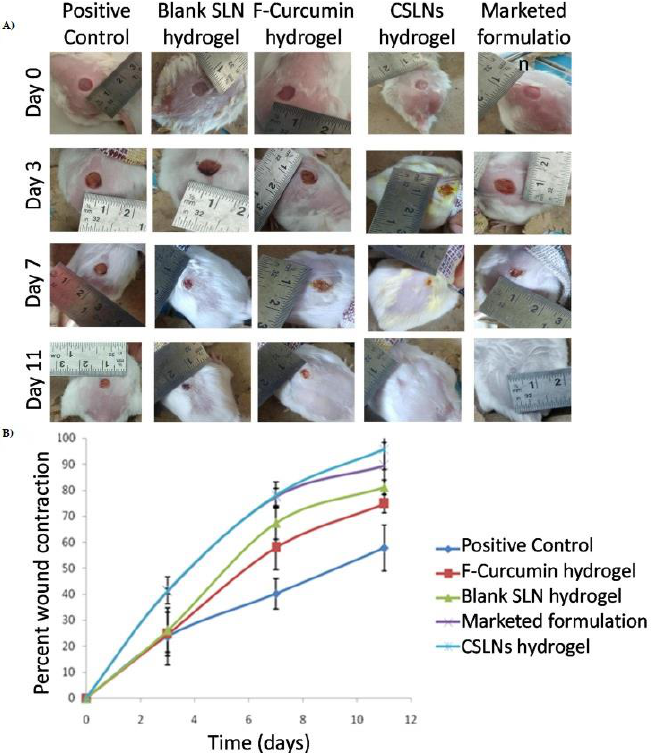
Figure 5. Effect of the treatments in the wound healing process. ( A ) Representative images of the wound healing process taken on day 0, day 3, day 7, and day 11 over the treatment; ( B ) Comparison of the percent wound contraction over the treatment. Data are available at 10.3390/antiox10050725